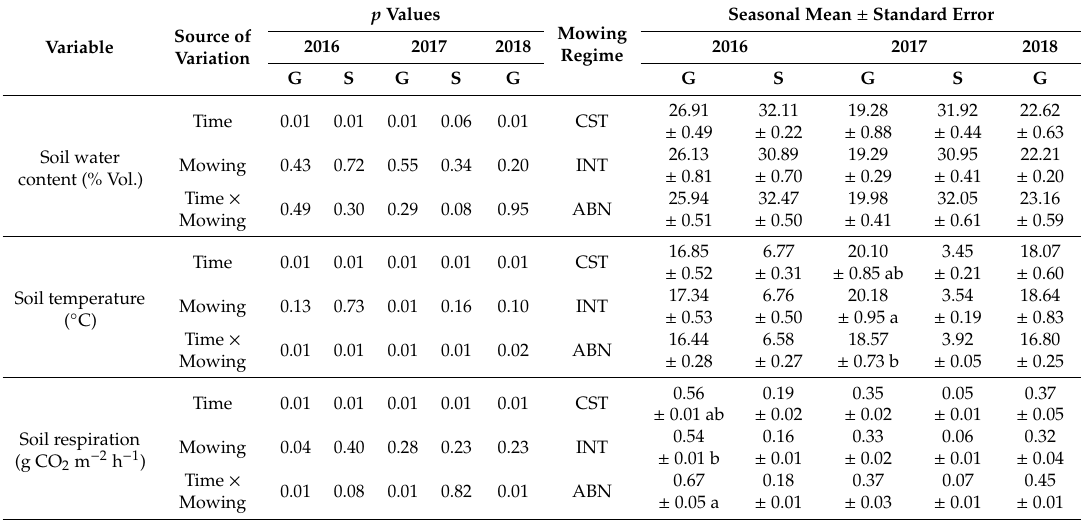
Table 1. Repeated measure ANOVA for soil water content, temperature, and respiration during the growing periods (G) and the vegetative stasis (S) for customary management (CST), intensive use (INT), and abandonment (ABN). Di ff erent letters indicate significant di ff erences (Tukey HSD test, p < 0.05). p Values Source of Variable Variation